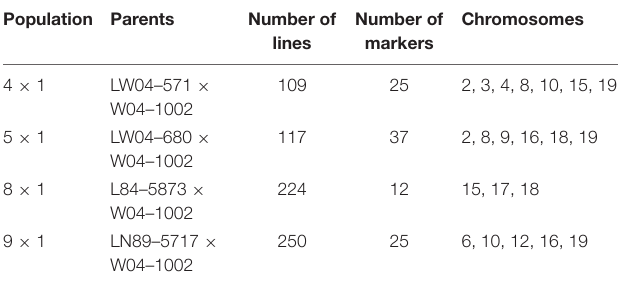
TABLE 3 | The parents of the populations tested for resistance and genetic markers, the number of lines in each population, the number of markers used to test the populations, and the chromosomes where markers are